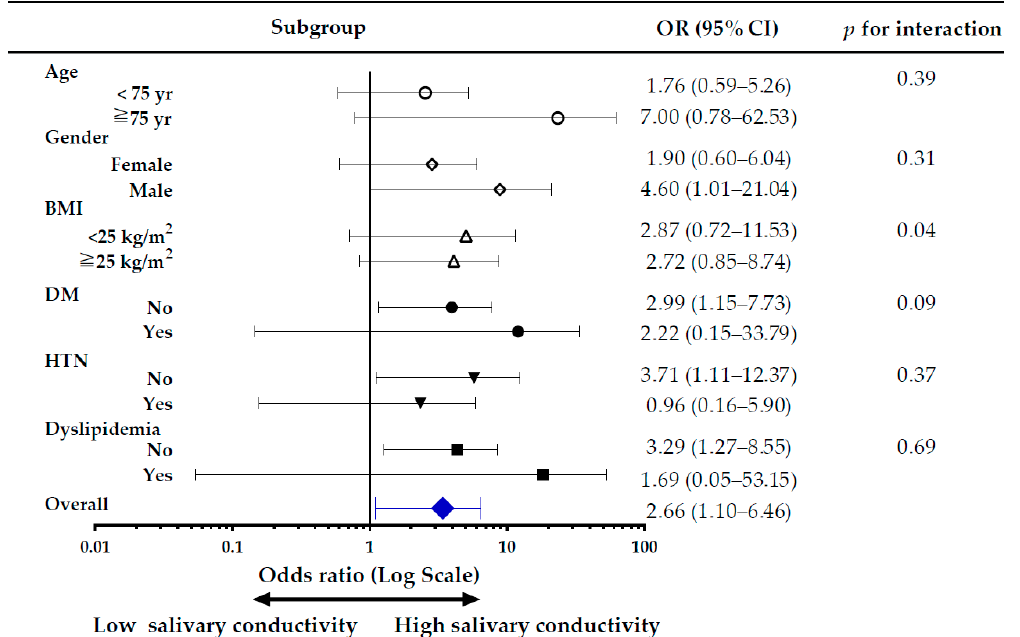
Figure 7. Forest plot for subgroup analysis of CKD risk. The adjusted odds ratio (OR) is for the high versus low salivary conductivity group. Study subjects were divided into high and low salivary conductivity groups based on the cutoff value of the ROC curve analysis (6.59 ms/cm). BMI, body mass index; CKD, chronic kidney disease; DM, diabetes mellitus; HTN, hypertension.